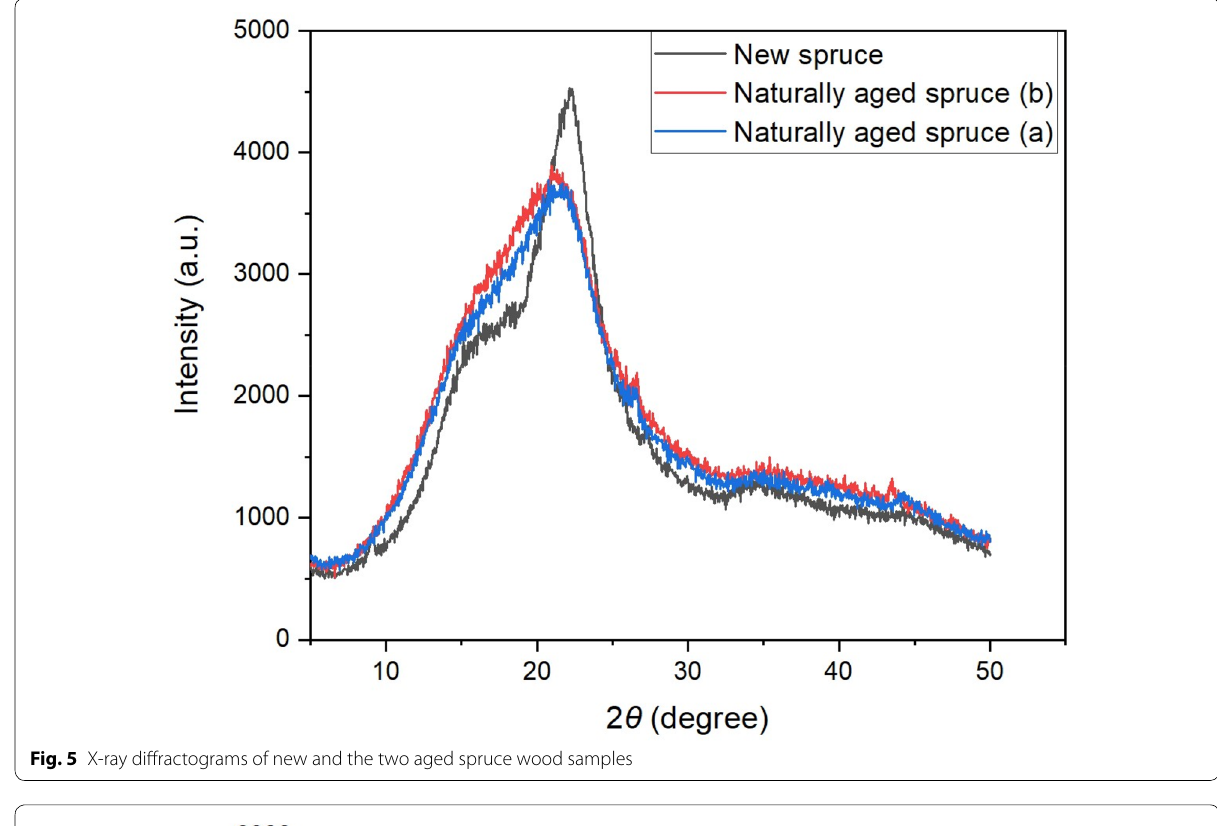
Fig. 5 X-ray diffractograms of new and the two aged spruce wood samples